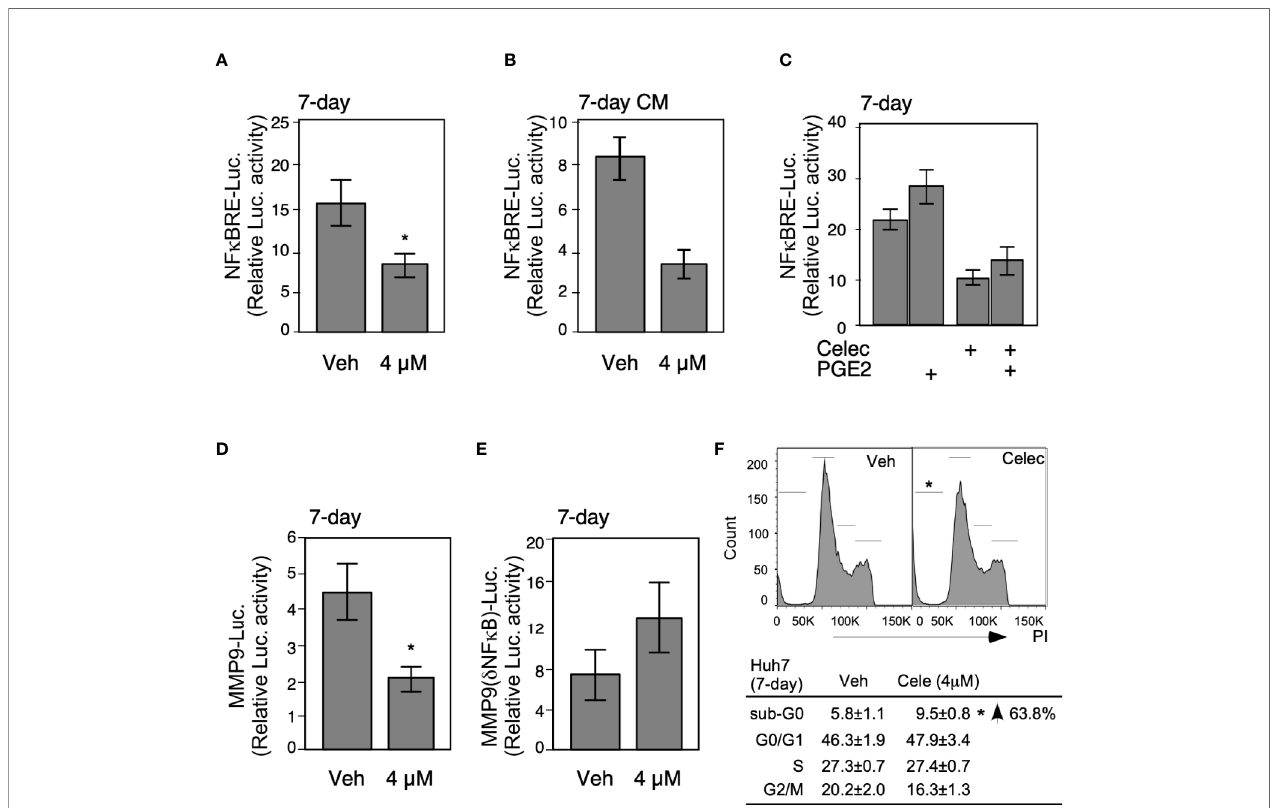
FIGURE 4 | Metronomic Celecoxib treatments suppress HCC cell invasion through NF k B-MMP9 pathway. (A) The metronomic Celecoxib treatment suppressed NF k B response element (NF k BRE) activity in HepG2 cells. The HepG2 cells were treated with Celecoxib 4 m M for 4 days and transfected with a NF k BRE – luciferase construct; then, treatment was continued for another 3 days. The dual-luciferase activity was measured on the seventh day of treatments. (B) The conditioned medium from the HepG2 cells treated with metronomic Celecoxib suppressed NF k BRE activity. The conditioned medium obtained from the HepG2 cells treated with celecoxib (4 m M) for 7 days were used to treat the HepG2 cells containing the NF k BRE – luciferase construct to measure dual-luciferase activity. (C) PGE2 cotreatment did not rescue NF k BRE – luciferase activity inhibition caused by metronomic Celecoxib treatment. The HepG2 cells were treated with either Celecoxib 4 m M or PGE2 1 m M for 4 days, transfected with NF k BRE – luciferase construct, and treated again with Celecoxib or PGE2 for another 3 days. The dual-luciferase activity was measured at the seventh day of treatments. (D, E) The suppression of invasiveness by metronomic Celecoxib treatment could partially go through the NF k B-MMP9 pathway. Similar treatments [as (A) ] were applied on the HepG2 cells, but transfected with MMP9 wild-type promoter (MMP9-luciferase; (D) construct, or NF k BRE deletion mutant of MMP9 promoter (MMP9 – ( D NF k BRE) – luciferase; (E) constructs to measure luciferase activity. The data were from at least four reproducible independent experiments in which the mean values with standard errors were plotted on graph. (F) The cell-cycle and sub-G0 population were measured in Huh7 cells treated w/wo metronomic celecoxib regimen. * Indicates P <